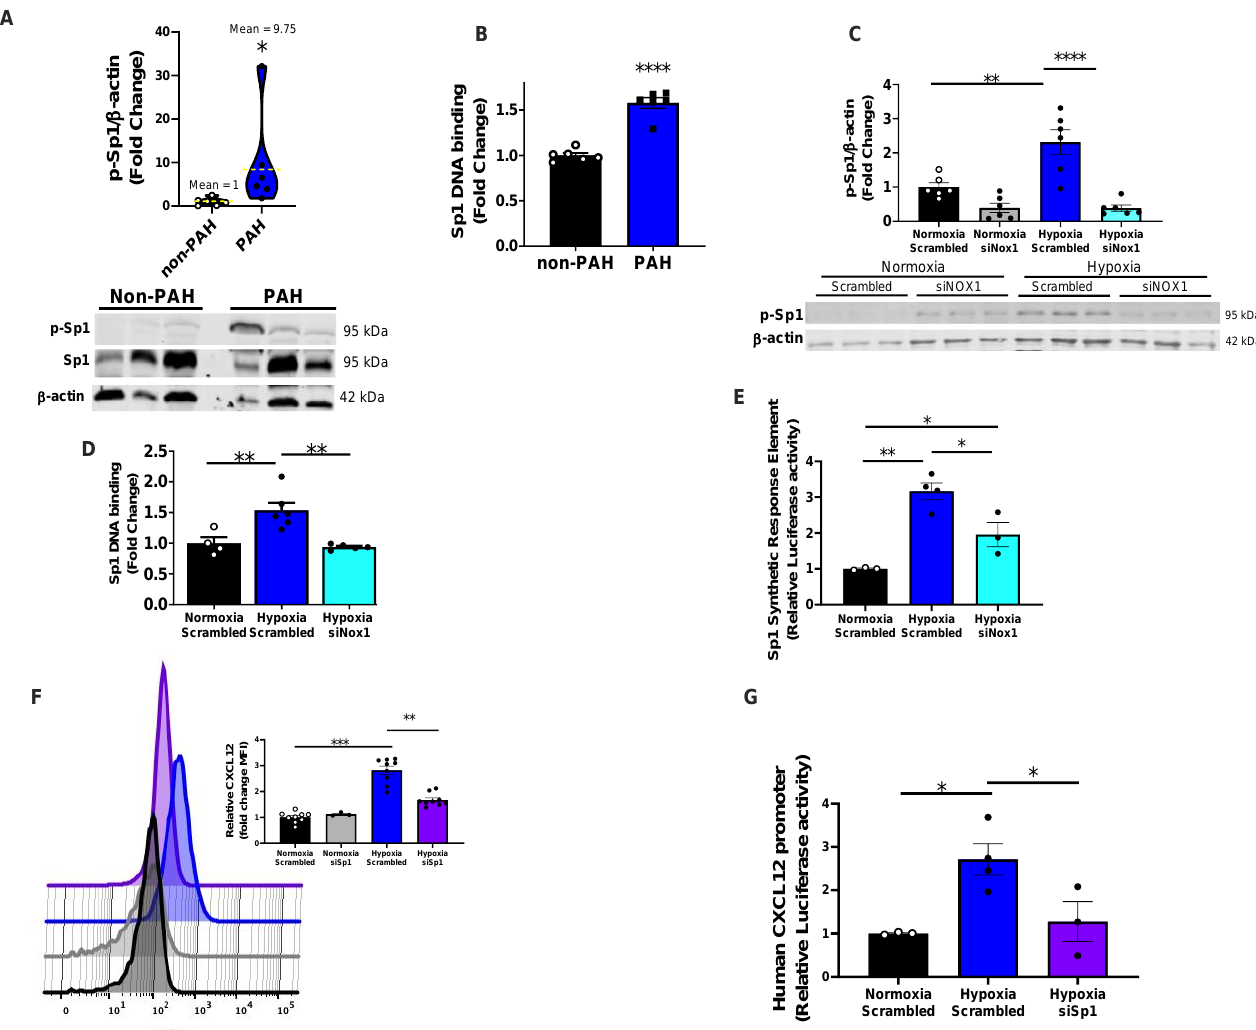
Figure 2. NOX1 activates the transcription factor specificity protein 1 (Sp1), Sp1 consensus DNA binding, and CXCL12 gene promotion. ( A ) Western blot analysis of human lung lysates for p-Sp1/ β -actin (n = 6). ( B ) Sp1 consensus DNA binding activity in human lung lysates measured by Active Motif TransAM assay (n = 6). ( C ) hPAECs transfected with scrambled or NOX1-targeted siRNA for 24 h were exposed to 1% O 2 and analyzed by Western blot for Sp1 activation, p-Sp1/ β -actin (n = 3–6). ( D ) hPAECs transfected with scrambled or NOX1-targeted siRNA for 24 h were exposed to 1% O 2 and analyzed by Active Motif Trans AM assay. ( E ) Sp1 transcriptional activation was tested in HUVECs transfected with SpRE luciferase plasmid in addition to scrambled or NOX1-targeted siRNA. Cells were placed in normoxia or 1% O 2 for 48 h and luciferase activity was measured by plate reader luminometer (n = 3–6). ( F ) hPAECs transfected with scrambled or Sp1-targeted siRNA for 24 h were exposed to 1% O 2 48 h. CXCL12 expression was measured by flow cytometry (n = 3–9). Representative flow cytometry histograms depict mean fluorescent intensity of FITC along the x axis, with a rightward shift of the peak indicating increased CXCL12 expression. ( G ) HUVECs transfected with luciferase reporter construct containing 1 kb of the human CXCL12 promoter were transfected with scrambled or Sp1-targeted siRNA. Cells were then exposed to 48 h hypoxia (1% O2) and Sp1 (cid:48) s ability to promote luciferase activity measured by plate reader luminometer (n = 3–4). Results were analyzed by Student t-test ( A , B ), one-way ANOVA followed by the Holm–Sidak test ( C – G ) * p < 0.05, ** p < 0.01, *** p < 0.001, **** p <